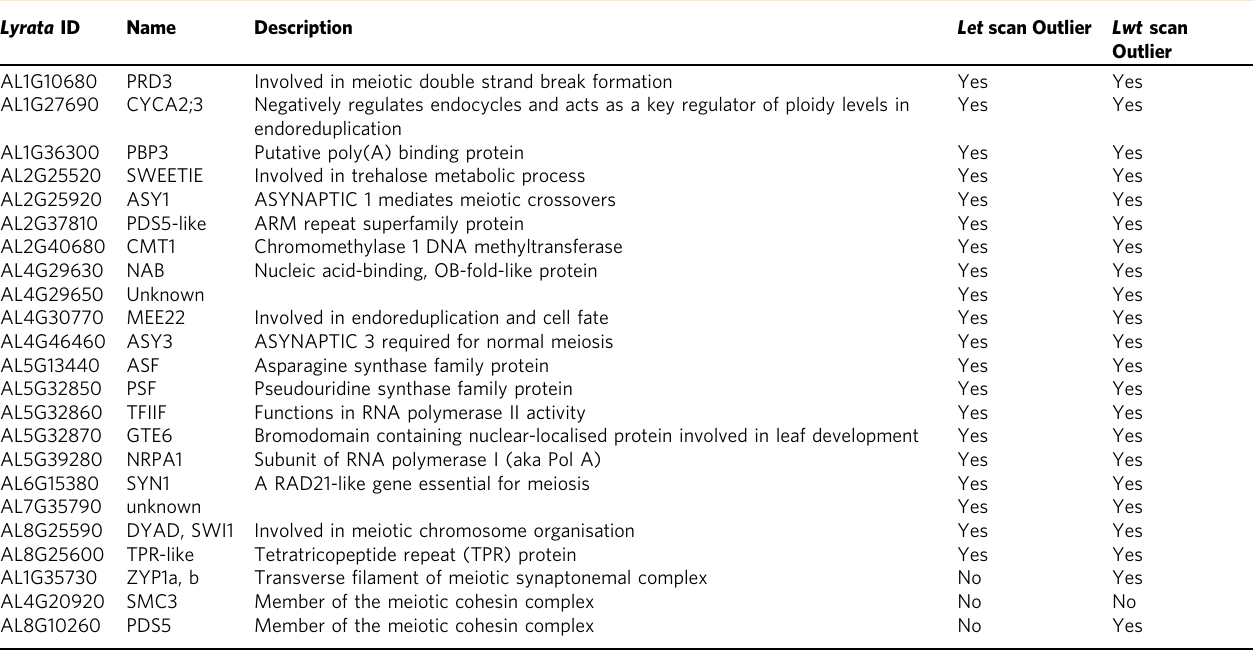
Table 2 Overlap list of the top 1% outliers from the genome scans Lyrata